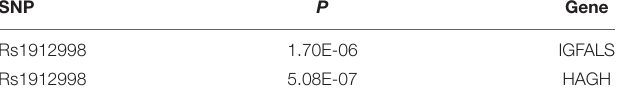
TABLE 1 | Significant SNPs in SMR test.